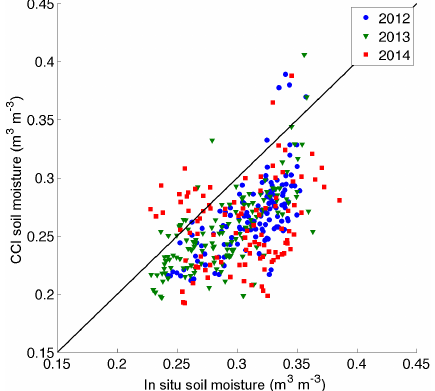
Figure 10. Scatter plot of daily averaged top soil layer ESA CCI soil moisture data product estimates using an exponential filter T param- eter value of 1 against spatially weighted areal average daily in situ observations for the years 2012, 2013, and 2014.